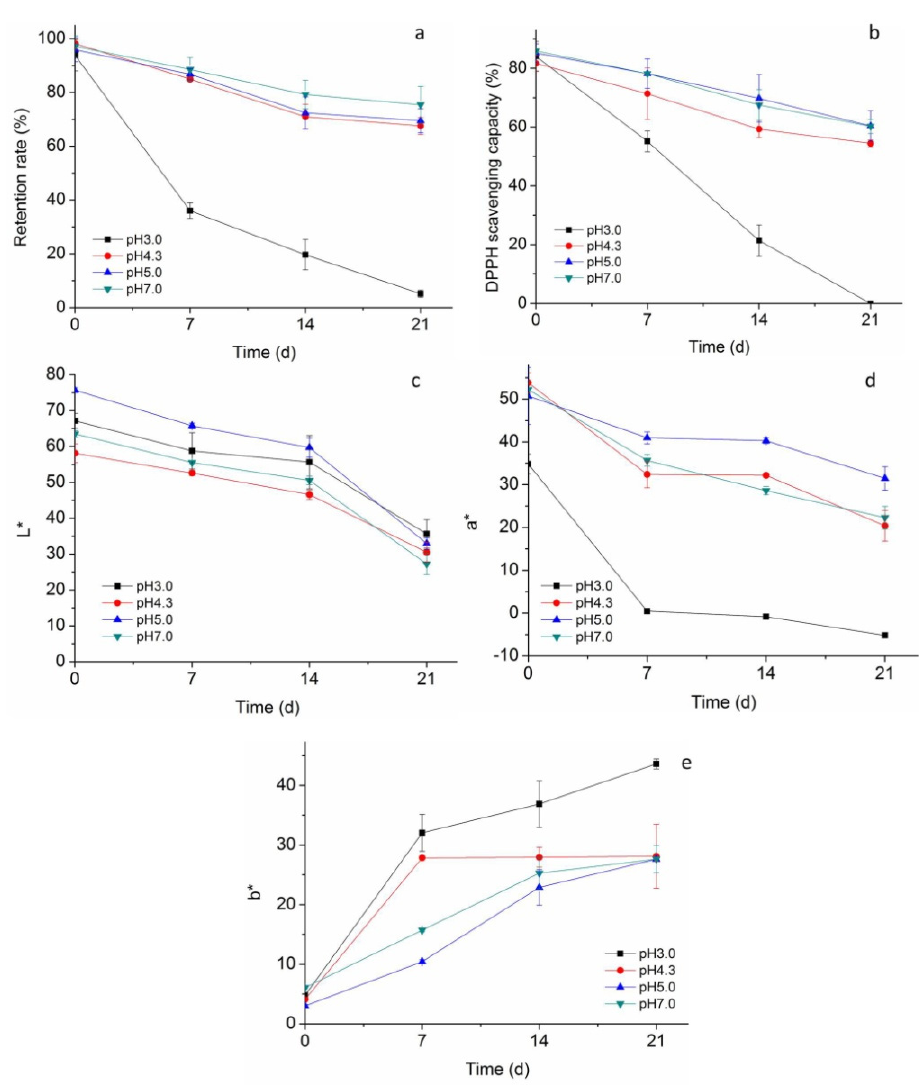
Figure 4. Stability of HPBL at different pH: ( a ) Retention rate; ( b ) DPPH scavenging activity; ( c ) L * value, which represents the color of lightness; ( d ) a * value, which represents the color rednesswhen the value is positive; ( e ) b * value, which represents the color of yellowness when the value is positive.